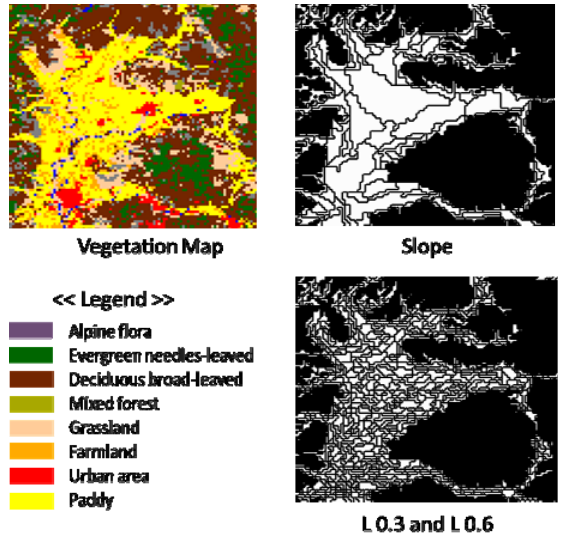
Figure 5. Segmentation of the plain area around Asahikawa